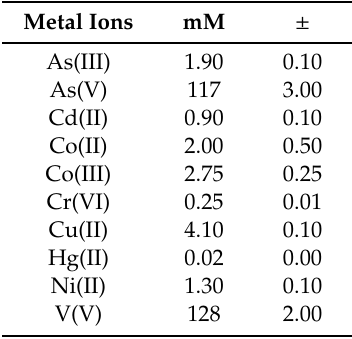
Table 1. G. stearothermophilus resistance to heavy-metal